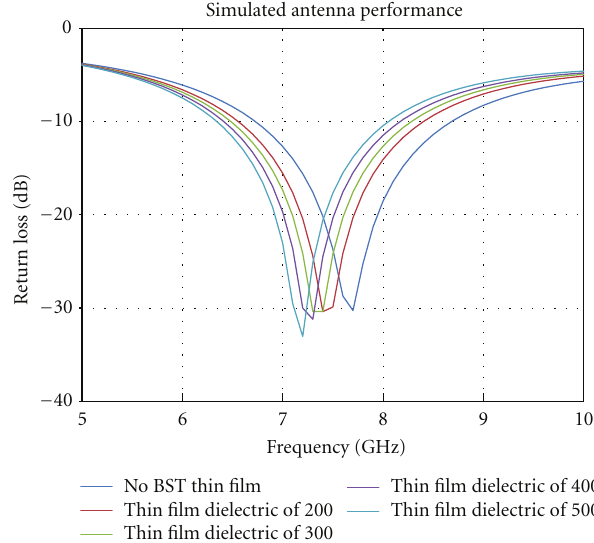
Figure 4: Radiation measurement setup in the RASCAL anechoic chamber. Figure 5: Bowtie antenna on di ff erent BST